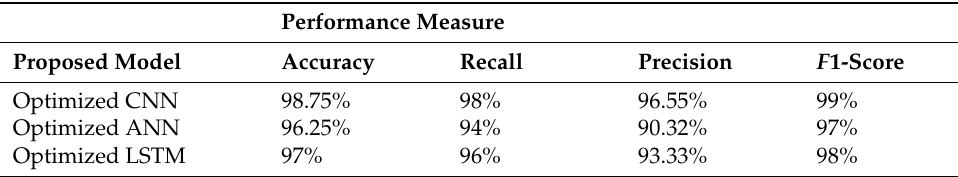
Table 3. Performance comparison of proposed